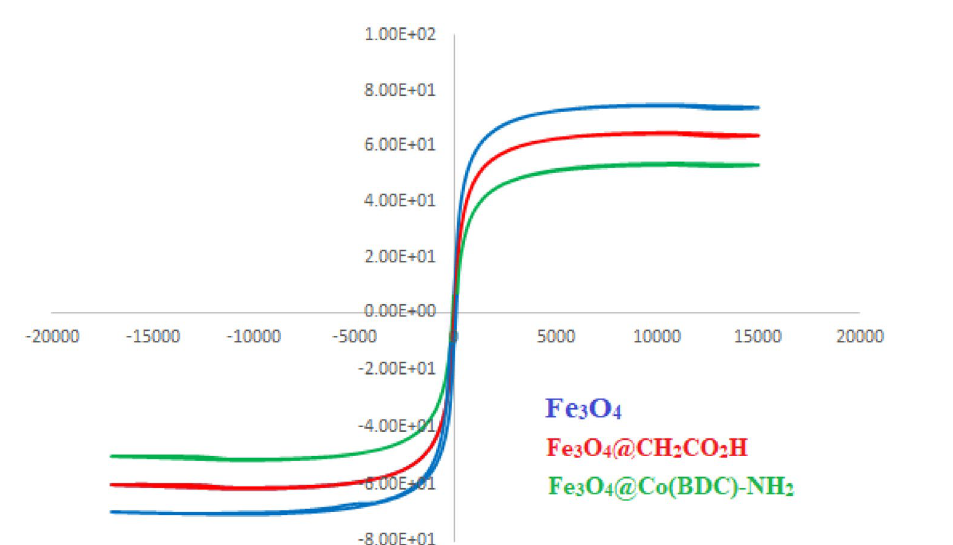
Figure 6. Vibrating sample magnetometer (VSM) of Fe 3 O 4, Fe 3 O 4 @CH 2 CO 2 H, and Fe 3 O 4 @Co(BDC)-NH 2